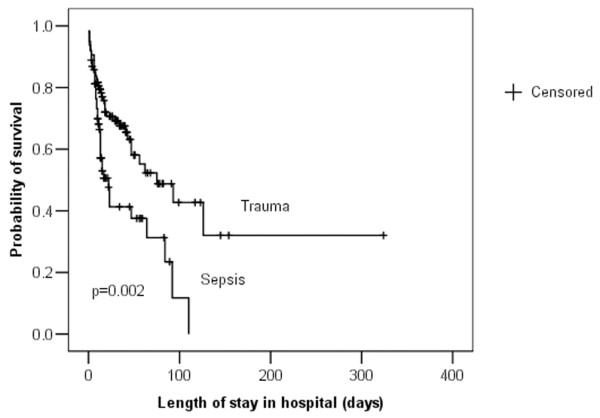
In-hospital mortality. The Kaplan-Meier survival curve shows that patients with sepsis had higher in-hospital mortality than did patients with trauma.